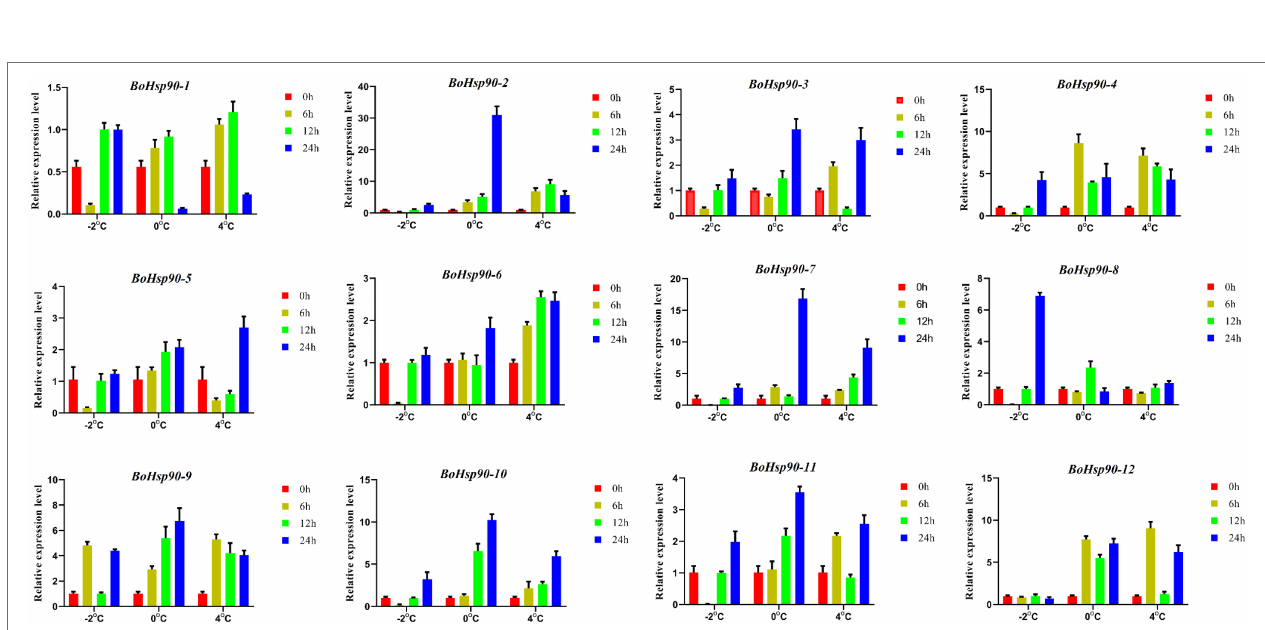
FIGURE 7 | Relative expression levels of 12 Hsp90 genes in B. oleracea leaves by qRT-PCR after 0 h (control), 6 h, 12 h and 24 h after treatment of cold stress at − 2 ° C, 0 ° C, and 4 ° C. The expression levels of Hsp90 genes were normalized to BoActin using as an internal control. Error bars indicate the standard error (SE) between three